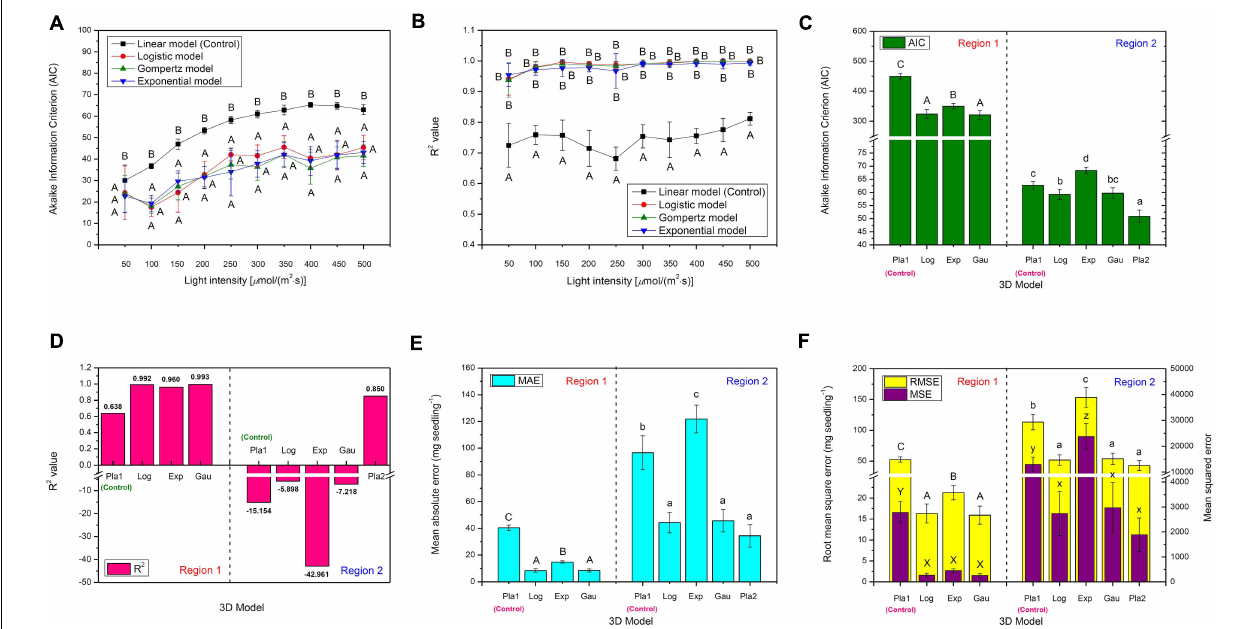
FIGURE 2 | The comparison of various 2D time-based growth models based on (A) Akaike Information Criterion (AIC) value and (B) R 2 value of choy sum seedling grown under different white LED light intensities, as well as the comparison of various 3D light-time-biomass response models based on (C) AIC value, (D) R 2 value, (E) Mean absolute error (MAE), and (F) Root mean square error (RMSE) and Mean squared error (MSE). Pla1, Plane1 model; Log, LogisticCum model; Exp, Exponential2D model; Gau, GaussCum model; Pla2, Plane2 model. Different upper cases (A, B, C, X, and Y) and lower cases (a, b, c, x, y, and z) indicate significant differences among all the 2D and 3D models tested [ n = 6, one-way analysis of variance (ANOVA); Tukey multiple comparison; p <